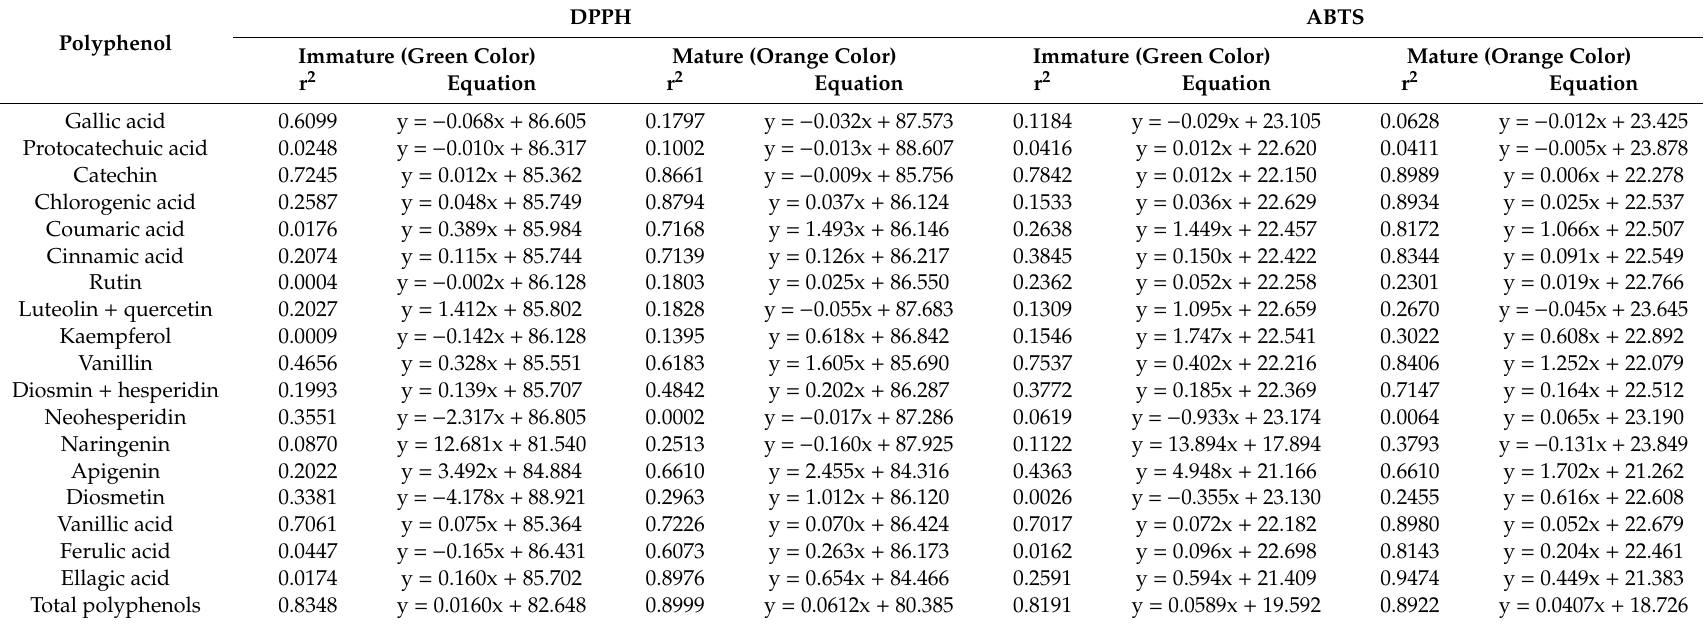
Table 3. Correlation of the concentration of polyphenols with the antioxidant activity determined by DPPH radical scavenging and ABTS assay in Capsicum chinense , and the equation of the linear correlation was